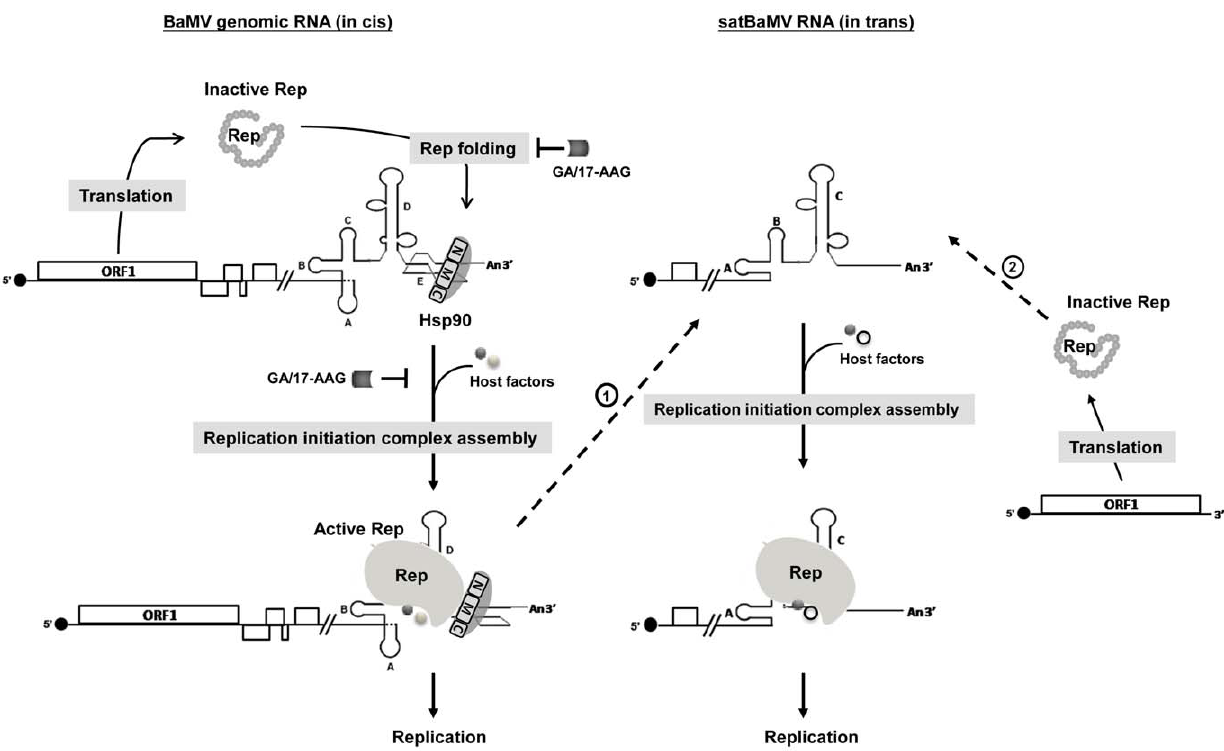
Figure 8. A proposed model illustrating the differential involvement of NbHsp90 in BaMV and satBaMV RNA replication. The scenario with BaMV genomic RNA is shown on the left and satBaMV RNA on the right. The 3 9 UTR regions are enlarged to depict various structural domains as indicated by capital letters A through E. NbHsp90 is represented by the long oval with N-terminal (N), middle (M), and C-terminal (C) domains shown. Following infection and uncoating, ORF1-encoded protein (Rep) is translated using BaMV genomic RNA as the template. Initially, the newly translated Rep is not properly folded, as represented by the irregular string of grey circles. NbHsp90 is thought to be involved in both the proper folding of BaMV Rep and the recruitment of BaMV RNA template in the early stage of replication. Firstly, Hsp90 inhibitors GA or 17-AAG can inhibit NbHsp90, whose chaperone activity assists in the proper folding of Rep (represented by light grey ovals) and in the assembly of active replicase complexes with other host factors. Once the active replicase complexes are assembled, the GA or 17-AAG inhibitory effects (represented by the T-shaped line) are alleviated. Secondly, the NbHsp90 RNA-binding domain (M-domain), which is insensitive to inhibition by GA or 17-AAG, interacts specifically with domain E of BaMV 3 9 UTR and recruits templates into the active replicase complexes. Alternatively, NbHsp90 may bind to BaMV 3 9 UTR first and facilitate both the proper folding of Rep as it is newly translated and the assembly of a replication initiation complex on the BaMV 3 9 UTR. By contrast, the satBaMV RNA 3 9 UTR may have evolved efficient structures that serve as a scaffold for the proper folding of Rep in the absence of domain E, and facilitates the assembly of active replicase complexes with other host factors (indicated by the dashed line labeled ‘‘2’’). Additionally, satBaMV RNA may utilize the preformed replicase complexes on BaMV genomic RNA for their own replication (indicated by the dashed line labeled ‘‘1’’). Thus, replication of satBaMV RNA is independent of NbHsp90, and hence is insensitive to the inhibitory effects of GA and 17-AAG.